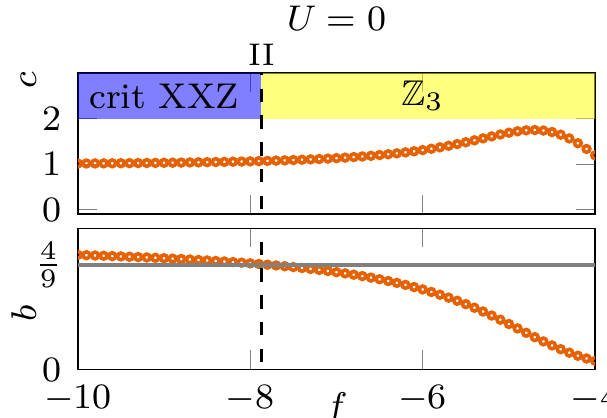
Figure 10: Numerical results for the (cid:90) -ANNNP model for L = 200 at U = 0. The top 3 and bottom panels show the central charge c and scaling exponent b , respectively. The solid horizontal line at b = 4 / 9 indicates the value of the exponent belonging to transition